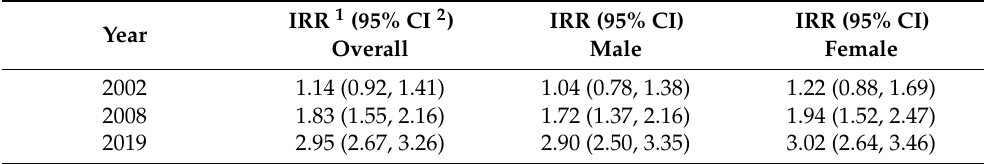
Table 2. Japan-to-Taiwan incidence rate ratios by gender, 2002, 2008, and 2019.